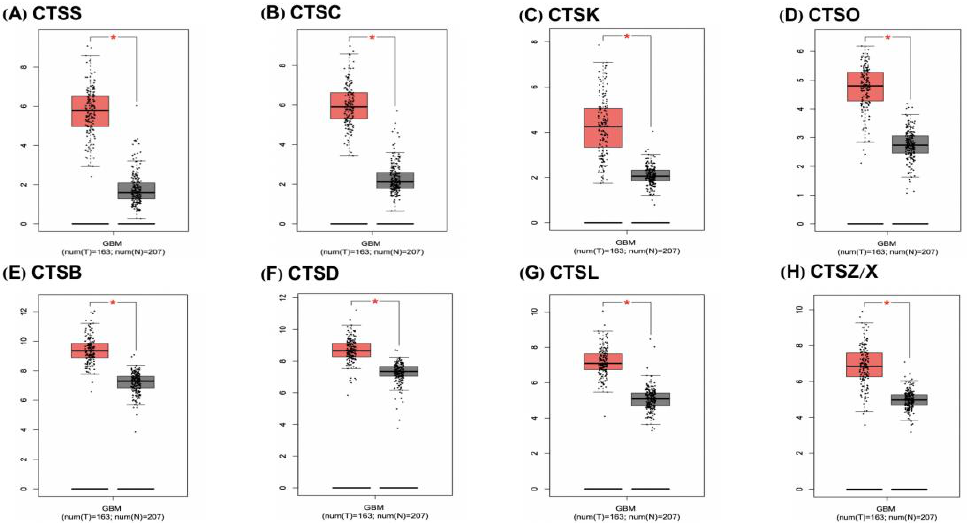
Figure 1. Cathepsin mRNA expression is upregulated in GBM patients. (A – H) Compared with normal tissues, CTSS, CTSC, CTSK, CTSO, CTSB, CTSD, CTSL, and CTSZ/X are highly expressed in tumors. Number of tumor samples (n = 163); number of tissue samples (n = 207). The red boxplot represents the tumor, and the grey boxplot represents the normal tissue. The data are presented as the mean ± SD, * P < 0.05 .